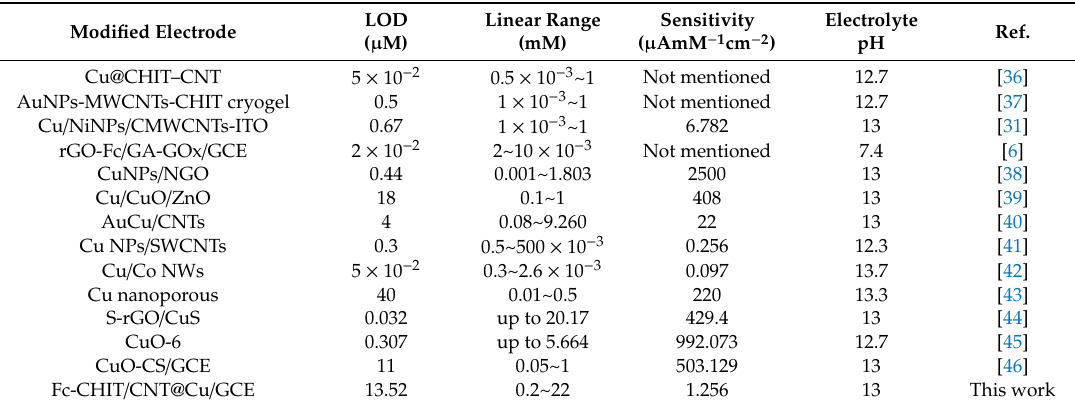
Figure 6. ( a ) Amperometric i-t curve response of serial concentrations of glucose obtained at the Fc-CHIT / CNT@Cu electrode. The di ff erence in the concentration of glucose was marked with arrow lines. ( b ) Plot for linear variation of current vs. glucose concentration of range of Fc-CHIT / CNT@Cu electrode (in glucose concentration range of 0.2–22 mM). Conditions: supporting electrolyte, 0.1 M NaOH; operating potential, 0.44 V. Table 1. Comparison of glucose detection using various sensing